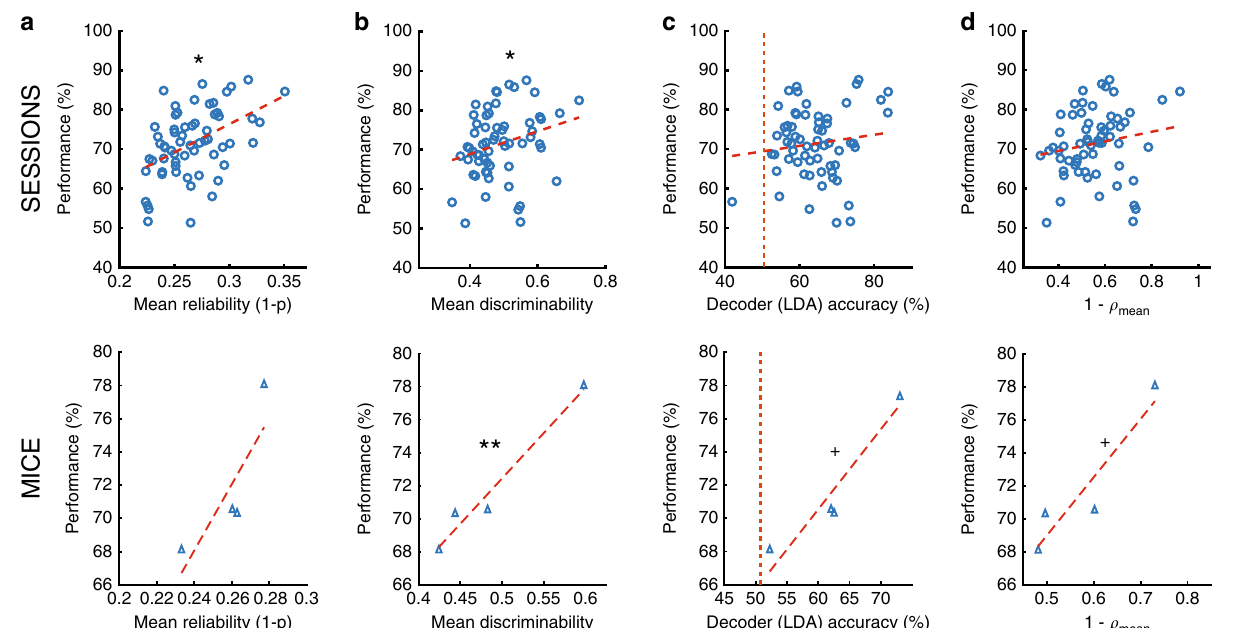
Fig. 3 The quality of trajectory-dependent activity correlates with performance. a (top) Performance for each session versus the mean reliability value for all cells active on the stem from that session. Circles = all sessions, all mice. * ρ = 0.47, p = 9.9 × 10 − 5 Pearson correlation. (bottom) Same as top but for each mouse, triangles = average for each mouse. b Same as a, but for the mean discriminability value. * ρ = 0.26, p = 0.039, ** ρ = 0.97, p = 0.017 Pearson correlation. c Same as ( a ), but for the mean LDA decoder accuracy. Dashed orange line indicates chance-level decoder accuracy assessed by shuf fl ing trial identity. + ρ = 0.89, p = 0.057, Pearson correlation. d Same as a, but for the mean value of 1 — Spearman ’ s ρ between left and right tuning curves. + ρ = 0.87, p = 0.066, Pearson